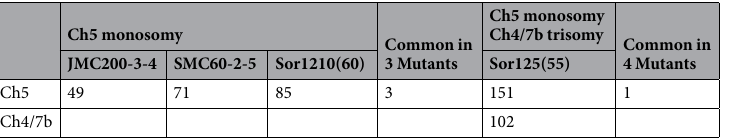
transcriptionally compensated to the diploid level of expression, which we took as mutant/parent gene ratios from 0.8 to 1.2. A total of 346 genes on monosomic Ch5 fit that criterion in at least one of the mutant strains: 49 (9.4%) in JMC200-3-4; 71 (13.6%) in SMC60-2-5; 85 (16.3%) in Sor1210(60); and 151 (31.5%) in Sor125(55) (Table 5). Pairwise comparisons of mutants revealed 6 genes regulated in common in both of the mutants gener- ated by caspofungin exposure, JMC200-3-4 and SMC60-2-5; 13 genes in JMC200-3-4 and Sor1210(60); 16 genes in JMC200-3-4 and Sor125(55); 32 genes in SMC60-2-5 and Sor1210(60); 34 genes in SMC60-2-5 and Sor125 (55); and 41 genes in both of the mutants generated by sorbose exposure Sor1210(60) and Sor125(55) that are also of the same genetic background (Fig. 3). Of six genes [ CUP1 (orf19.3940.1); SNM1 (orf19.1927); MES1 (orf19.3955); SGE1 (orf19.1942); and unchar- acterized orf19.577, and orf19.1121) shared between JMC200-3-4 and SMC60-2-5, three ( SGE1 , CUP1 , and orf19.1121) were similarly expressed at diploid level in the Sor1210(60) (Table 5). Among those only orf19.1121 was also expressed at diploid level in the sorbose-generated Sor125(55) that, unlike other mutants, harbors both